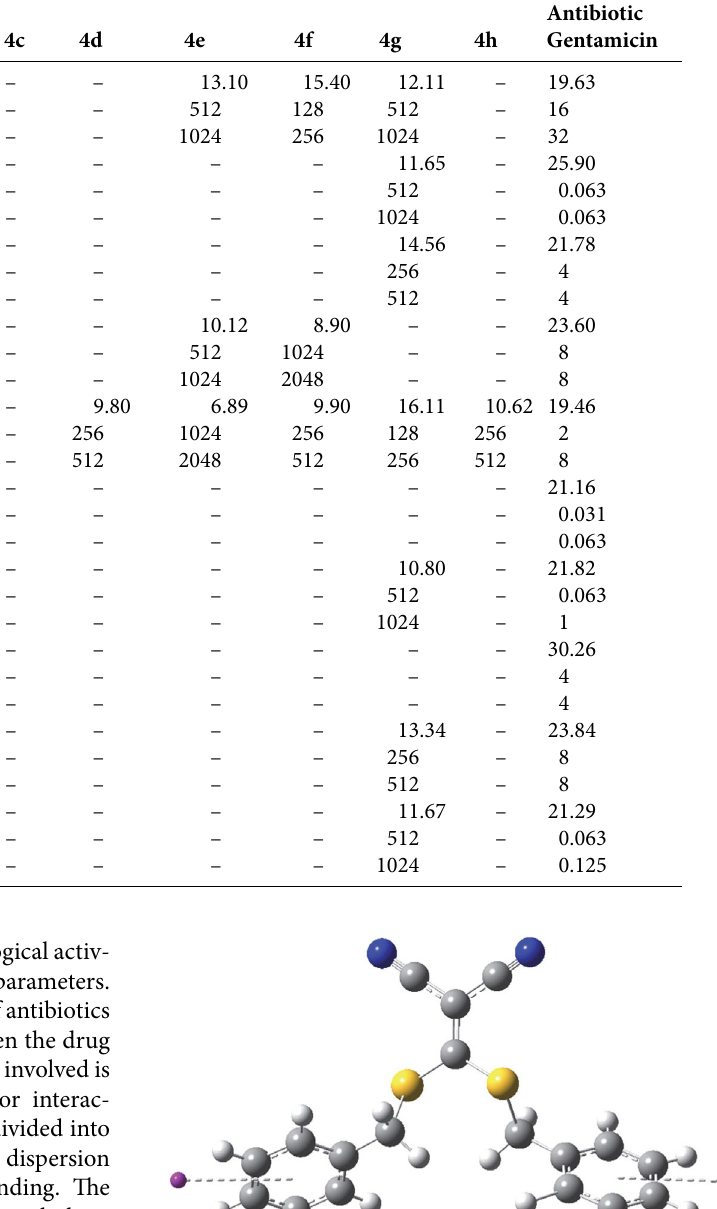
Table 2. Inhibitory activities of thioethers 4a–h against Gram–negative pathogenic bacteria. Bacteria Products